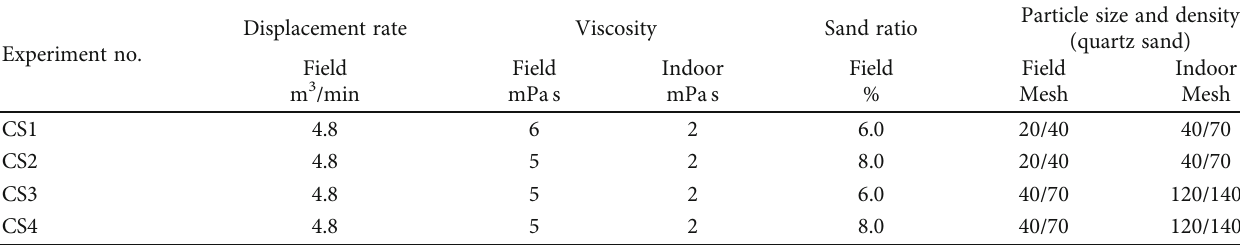
Table 4: Sand concentration exploration experiment scheme of LD C7.